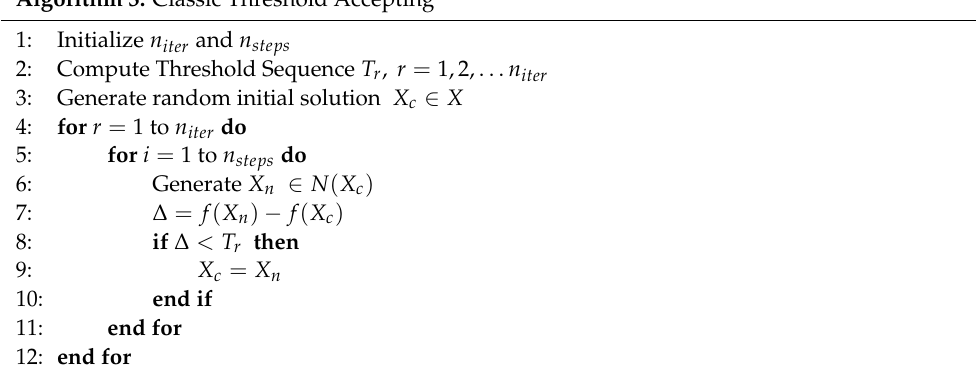
Algorithm 3. Classic Threshold